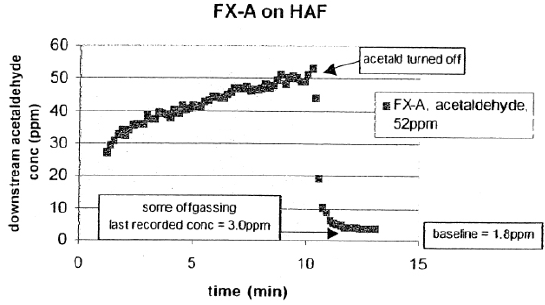
Figure 8. Sulphur dioxide trapping efficiency of base-treated